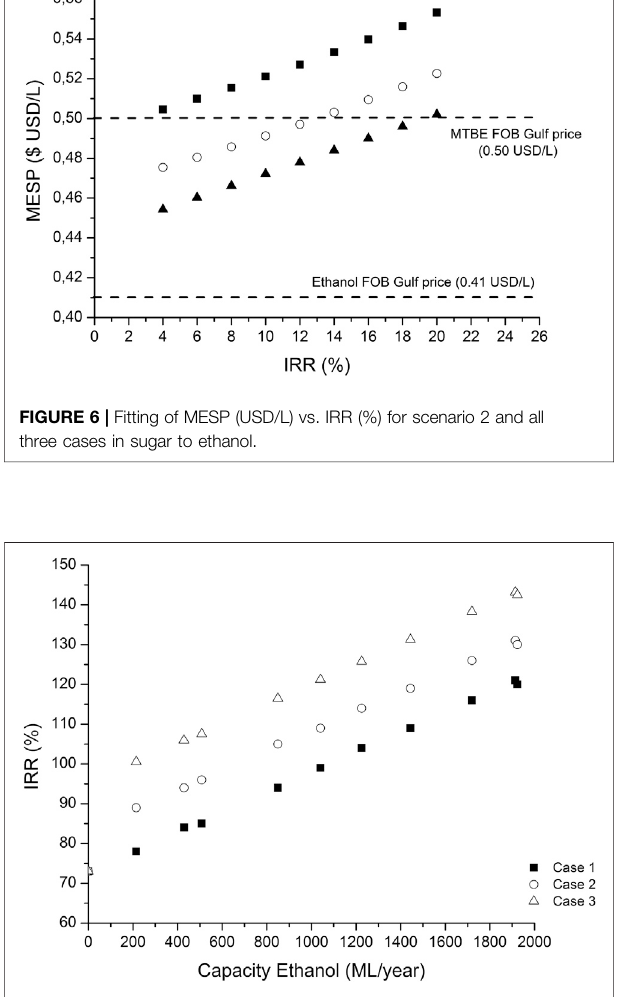
FIGURE 7 | IRR (%) vs. the capacity ethanol production (ML/year).